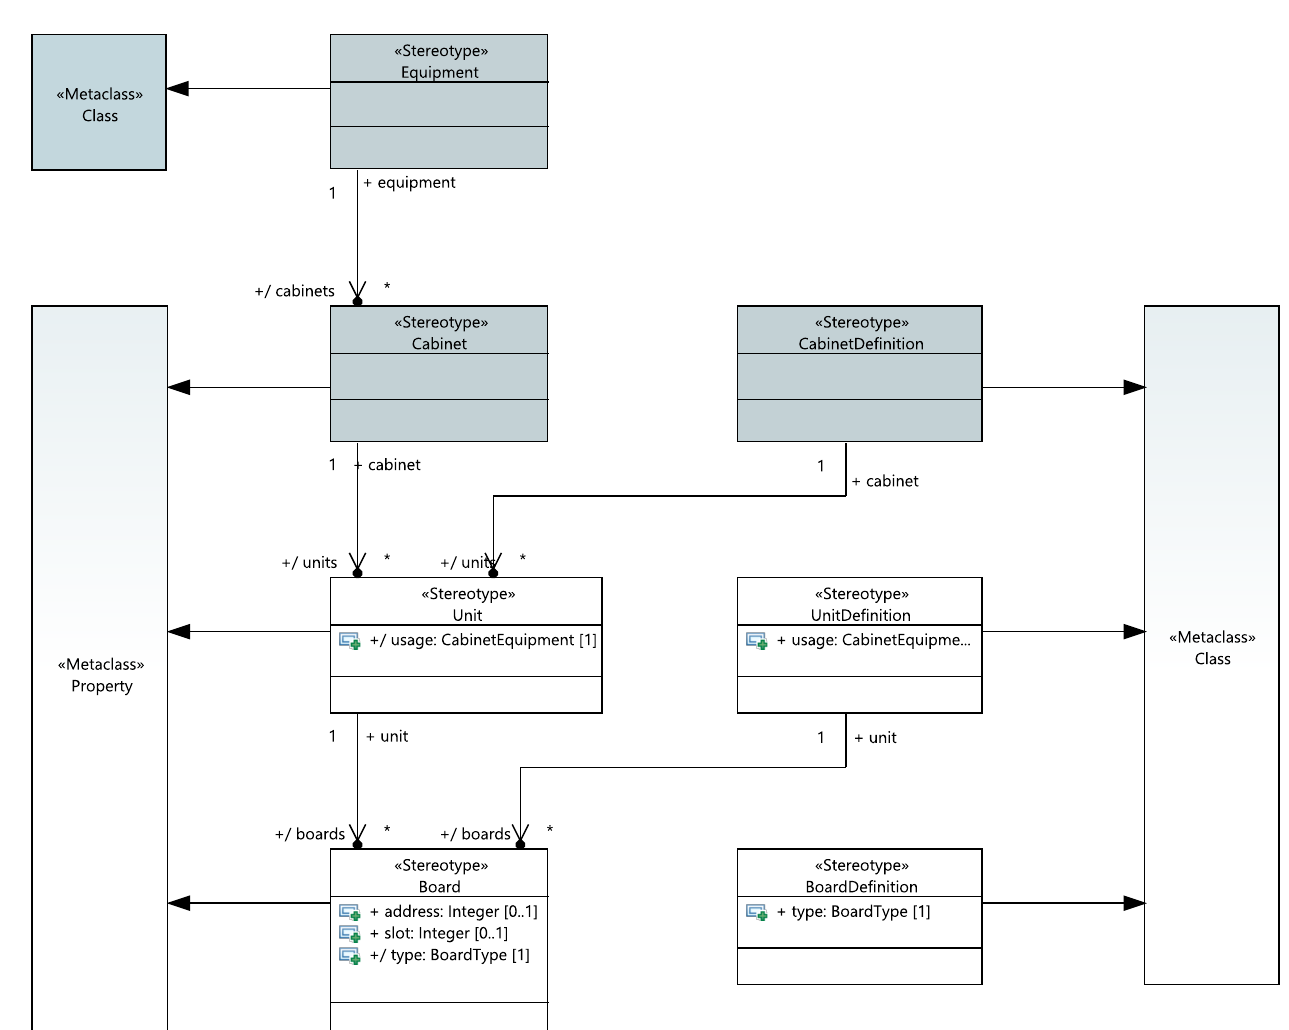
Figure 10. Meta-model of the physical